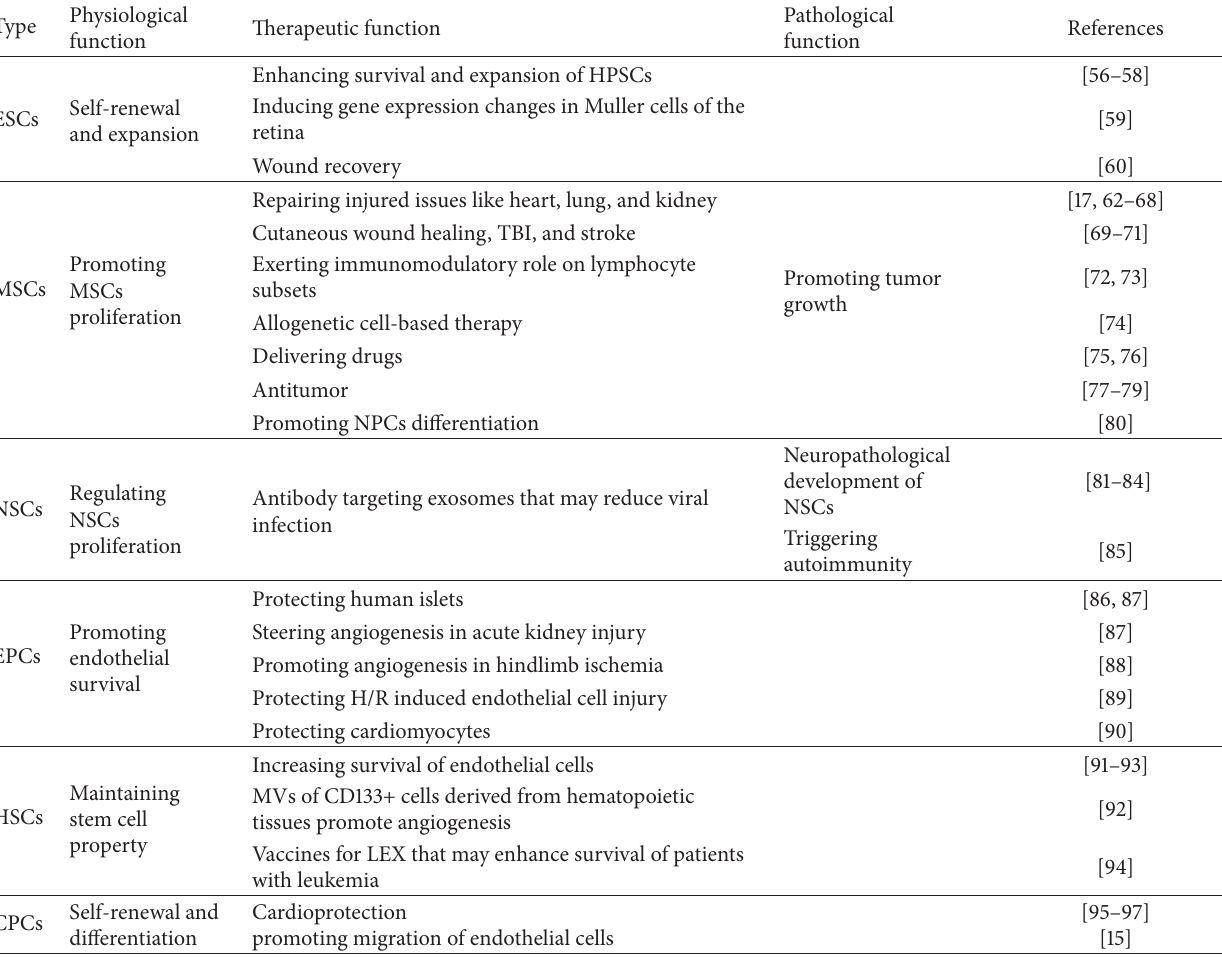
Table 1: The function of exosomes derived from different types of stem